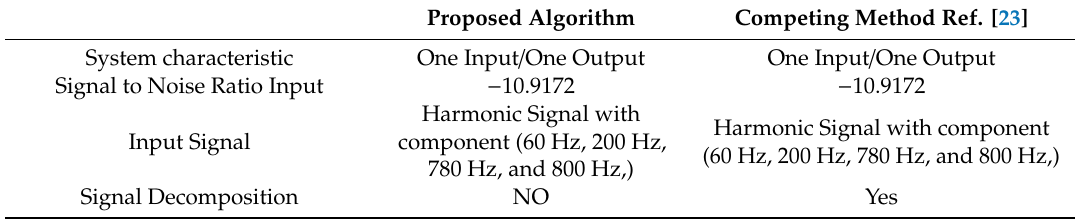
Table 1. Comparison of our proposed algorithm with the competing method proposed in [23].